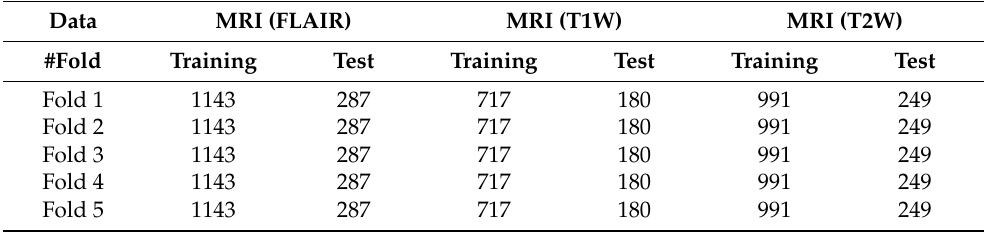
Table A2. Sample distribution of five-fold